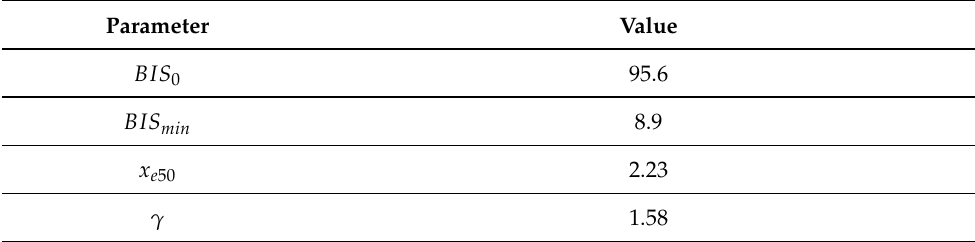
Table 2. Parameter